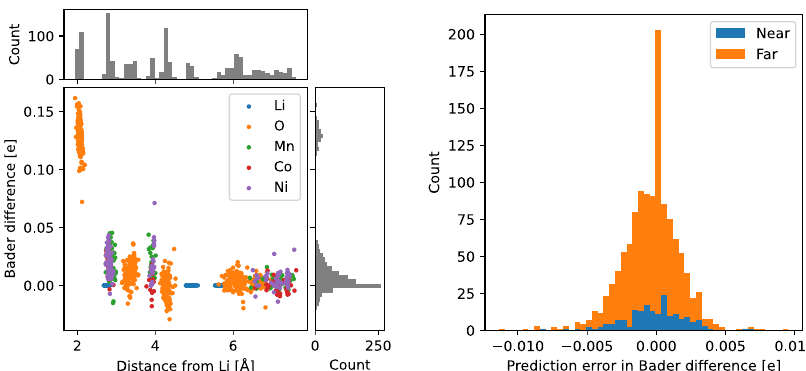
Fig. 8 Analysis of Bader charge difference of remaining atoms when removing a Li atom from NMC cathode. The scatter plot to the left shows the change in Bader charge for all atoms in the systems as a function of the distance from the Li being removed. The stacked histogram to the right shows the distribution of prediction errors of the machine learning model.